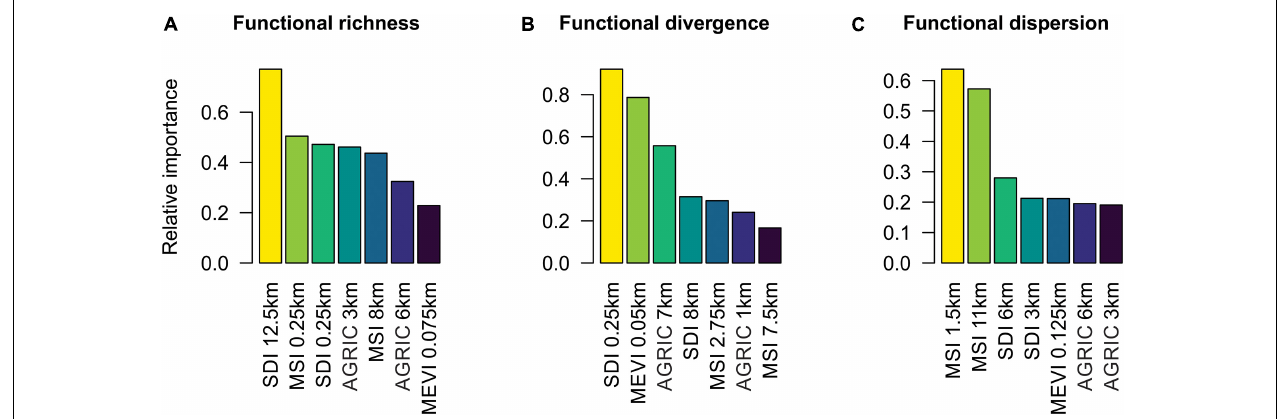
FIGURE 3 | Relative importance of environmental predictors on functional richness (A) , divergence (B) , and functional dispersion (C) . The relative importance is the sum of the Akaike information criterion weights of the models with each predictor. Shannon Diversity Index (SDI) was the best predictor for richness and functional divergence but in different spatial scales. Mean shape index (MSI) was the best predictor of functional dispersion at the proximal landscape level. The numbers associated with predictors represent the spatial scale with the highest R 2 value. MEVI2, mean vegetation index; AGRIC, proportion of